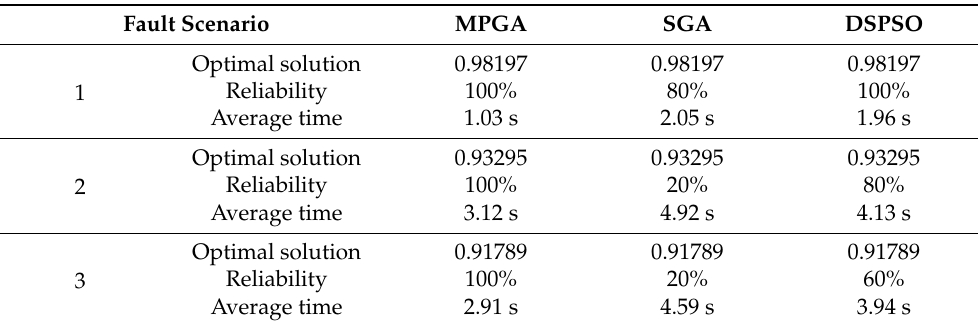
Table 2. Comparison results of the three methods. Fault Scenario MPGA